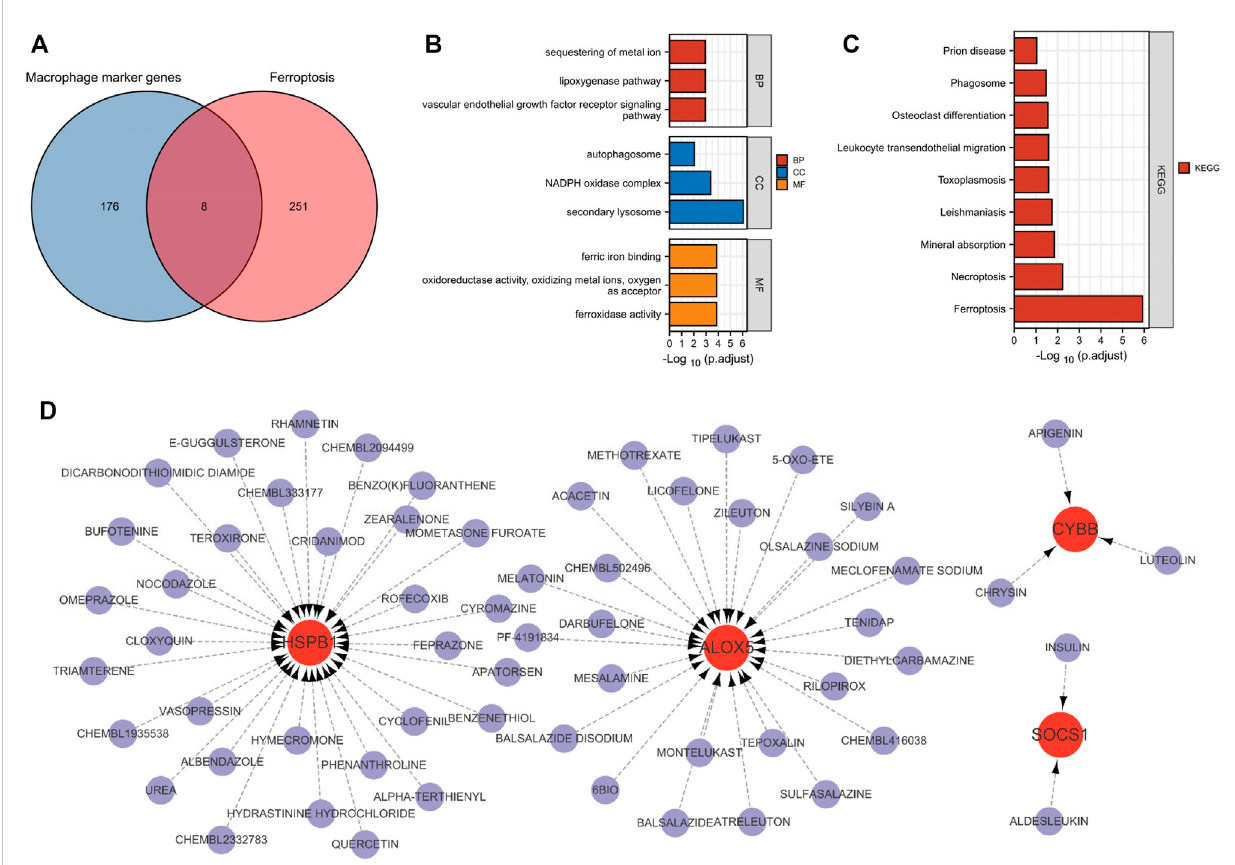
FIGURE 3 Macrophage ferroptosis-related genes identi fi cation and drug prediction. (A) Venn plot exhibiting the macrophage marker genes and ferroptosis- relatedgenes. (B,C) GOandKEGGanalysisofMacrophageferroptosis-relatedgenes. (D) Thedrugandmacrophageferroptosis-relatedgenesinteraction